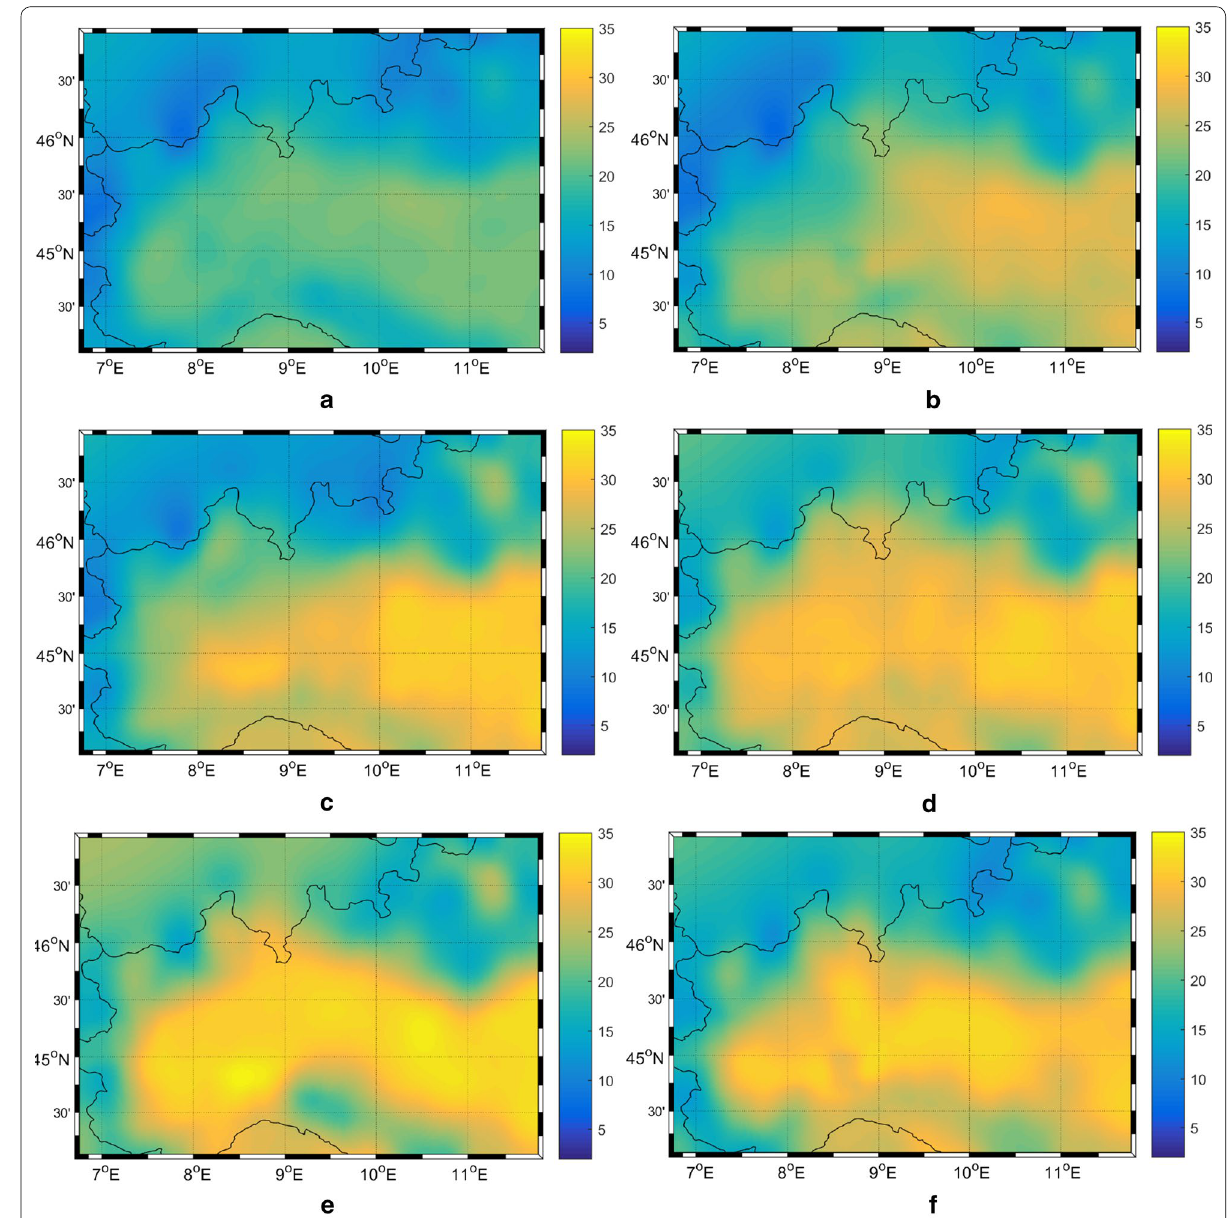
Fig. 5 Time progression of the July 22, 2016, event ( a , c , e ) and the July 26, 2016, event ( b , d , f ), as seen through temperature maps derived from weather stations observations. Temperature values in degrees Celsius. LT local time. a July 22—07:00 LT. b July 26—12:00 LT. c July 22—10:00 LT. d July 26—15:00 LT. e July 22—13:00 LT. f July 26—18:00